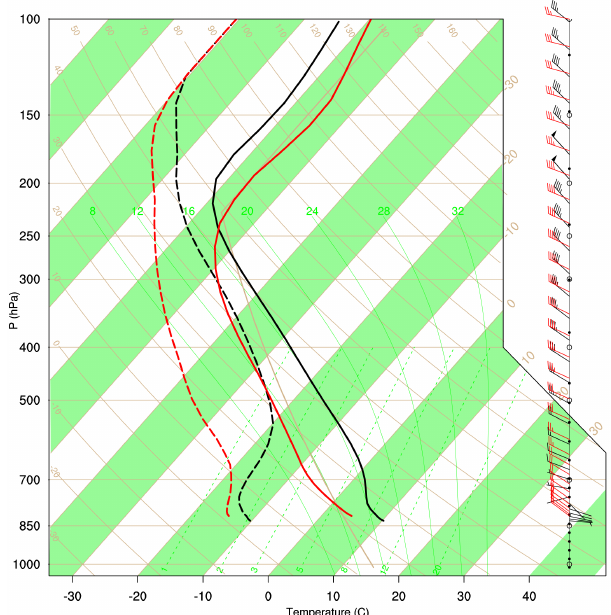
Figure 12. Skew T-log diagram over the TD (black lines) and GD (red lines) on 19 March 2010 from the WRF-Chem simulation. The solid lines represent the temperature, and the dashed lines represent the dew point temperature.